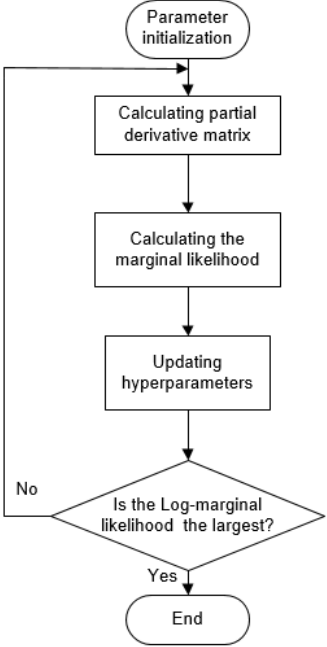
Figure 10. Training flowchart of optimizing hyperparameters. Hyperparameter training use gradient ascent and the termination contingency of the training process is that the logarithmic marginal likelihood value reaches the